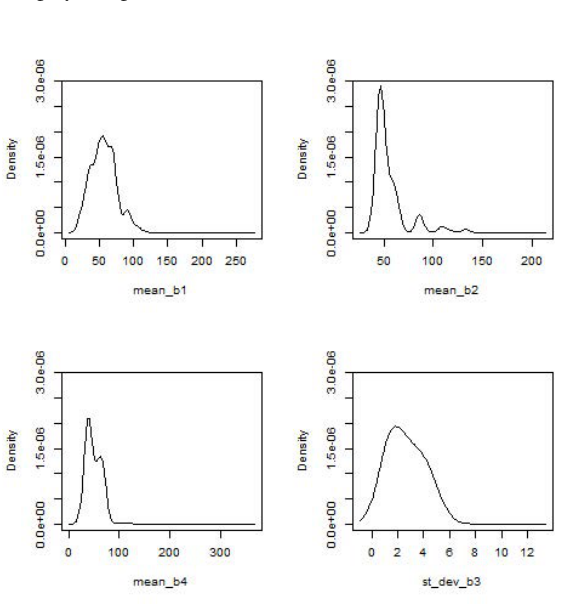
Figure 2: Density function per analysed